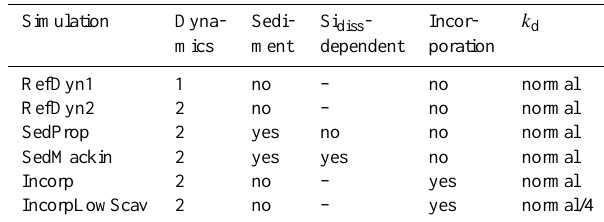
Table 3. Overview of the two reference simulations as defined in the text, and the two sets of sensitivity simulations as defined later in the text. If not specified otherwise, when the term reference simulation is used, we refer to RefDyn2. Here RefDyn1 refers to the old “ref- erence experiment” of Van Hulten et al. (2013). Dynamics 1 refers to the climatology based on ERS satellite data; Dynamics 2 is based on DFS3. The Si diss -dependence refers to the dependence on bot- tom water [Si diss ] for dissolution of resuspended adsorbed Al. The normal partition coefficient is k d = 112 × 10 3 dm 3 mol − 1 . This is equivalent to the k d = 4 × 10 6 dm 3 kg − 1 in Van Hulten et al. (2013), where the biogenic Si concentration was denoted in kgdm − 3 in- stead of moldm − 3 . For consistency in the concentration units, we changed the unit (and hence the value) of k d